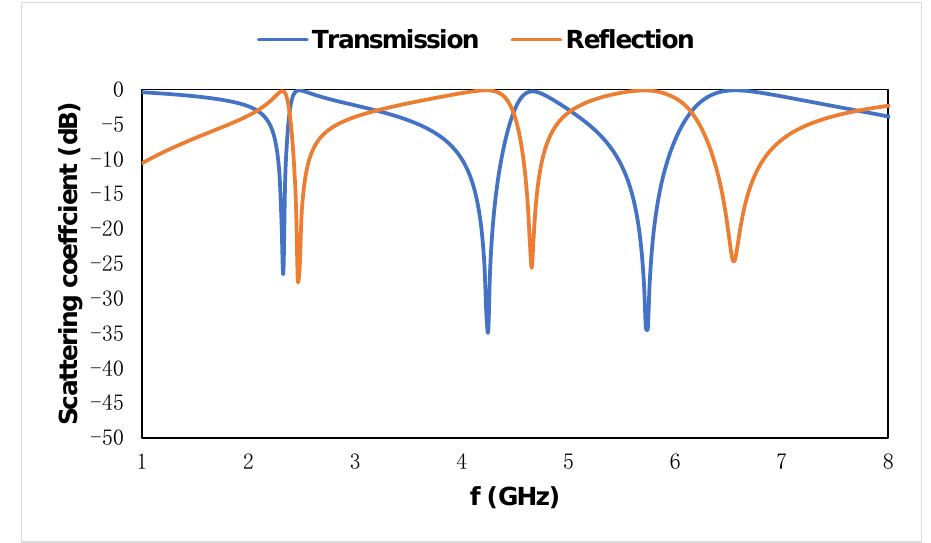
Figure 3. Scattering result of the proposed metamaterial unit cell.